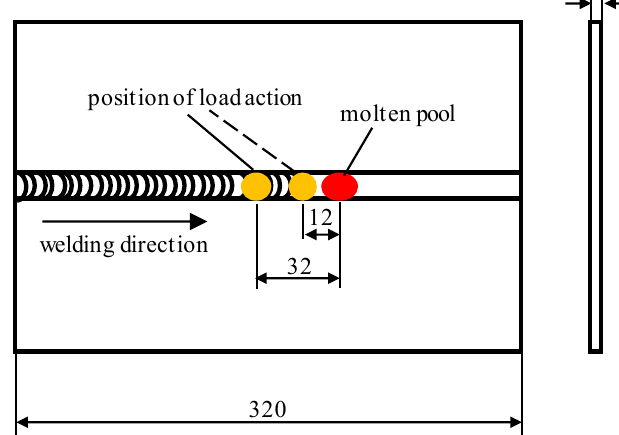
Figure 11. Adjustment range of the loading distance ( d ).